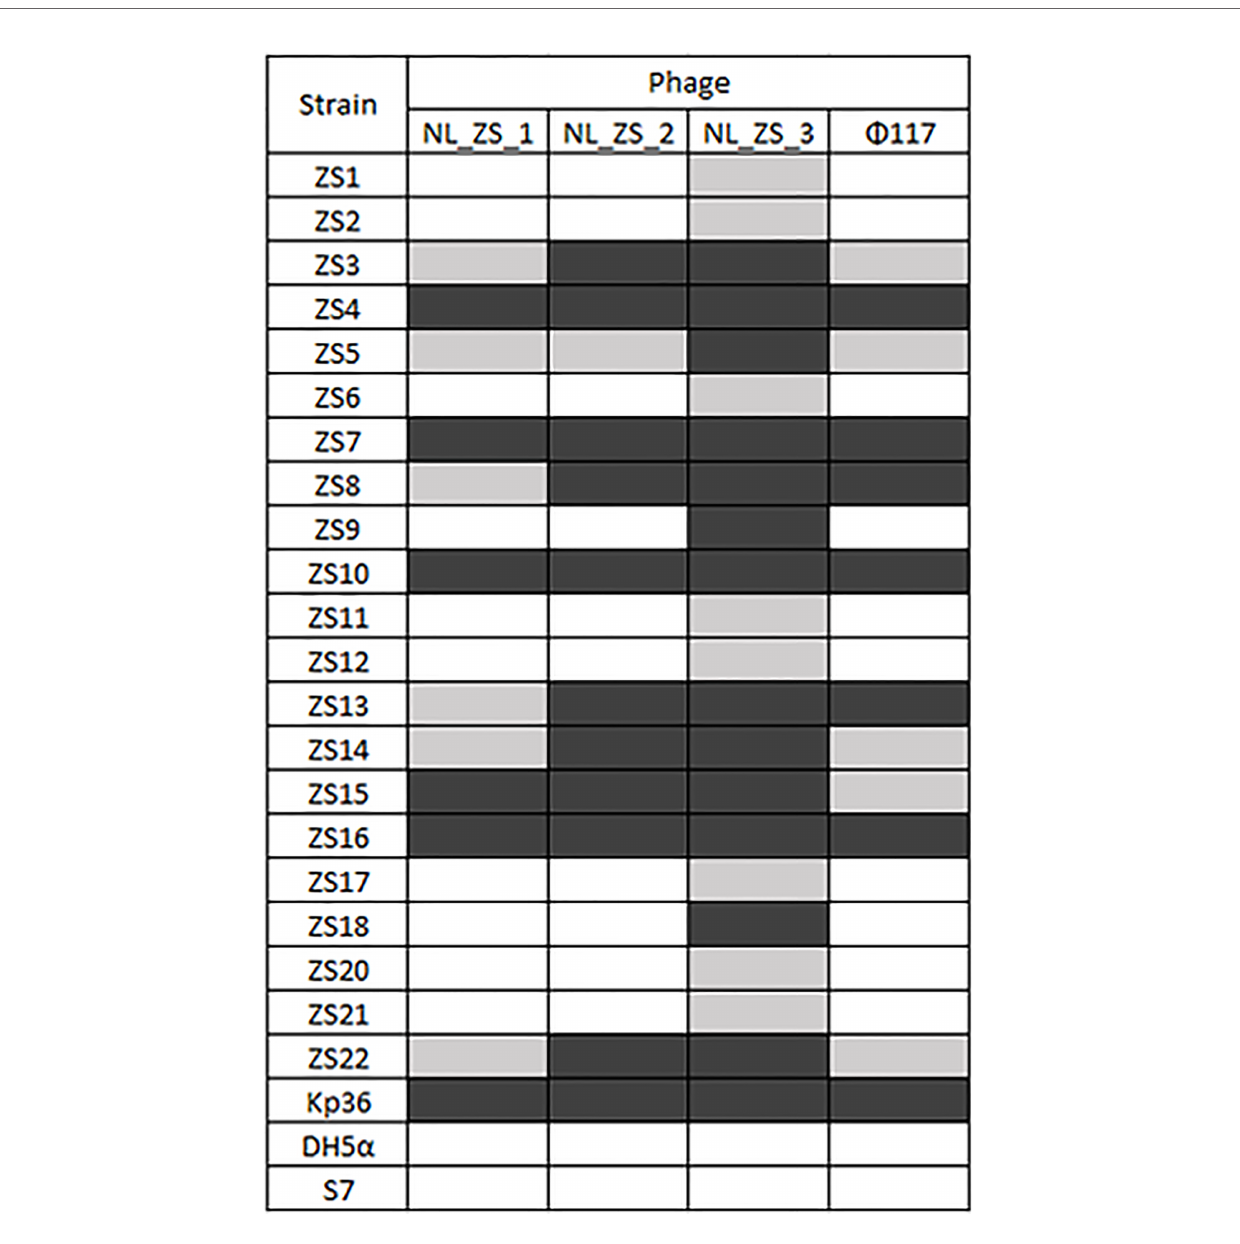
FIGURE 2 | Phage-host range assay of the 4 phages (columns) against the 22 K. pneumoniae strains and the reference strain Kp36, DH5 a , and S7 (rows). Klebsiella pneumoniae phages displayed broad and narrow host ranges. Black, grey and white indicate infection, weak infection and no plaque formation,